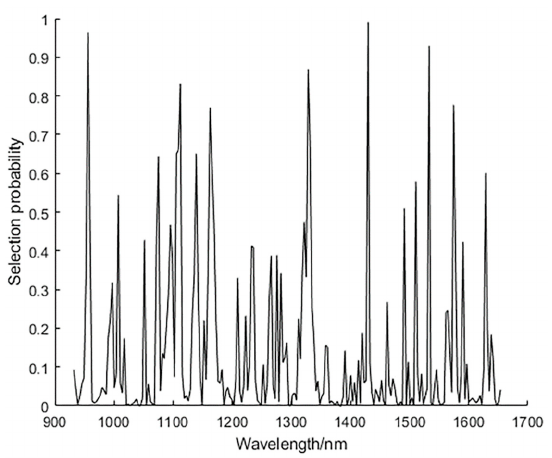
Figure 7. Using random frog (RF) algorithm to show the selection probability of each wavelength.